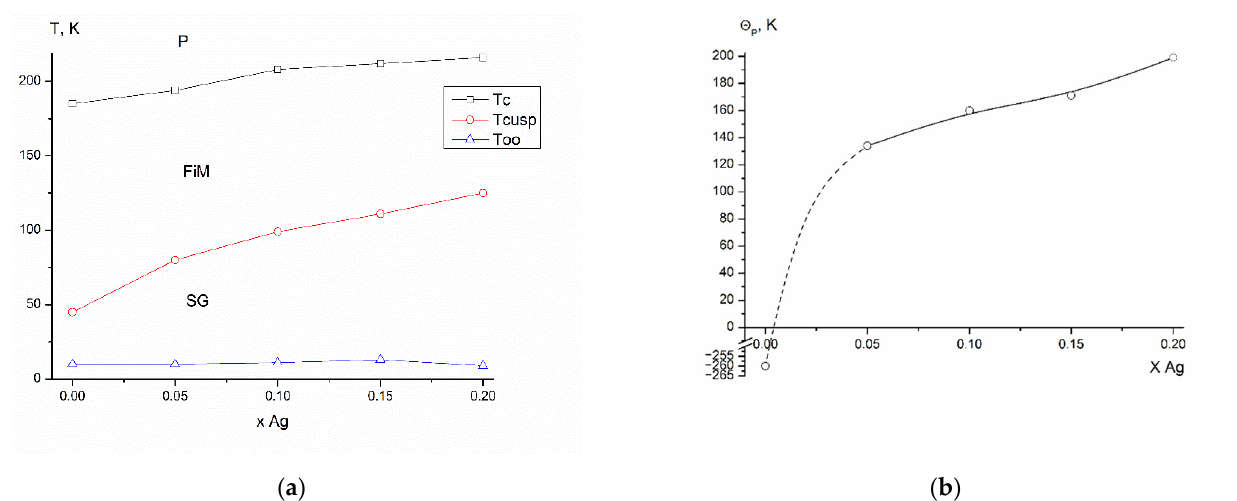
Figure 5. ( a ) Section of the magnetic phase diagram for Fe 1 − x Ag x Cr 2 S 4 . ( b ) Concentration dependence of the paramagnetic Curie temperature for Fe 1 − x Ag x Cr 2 S 4 .